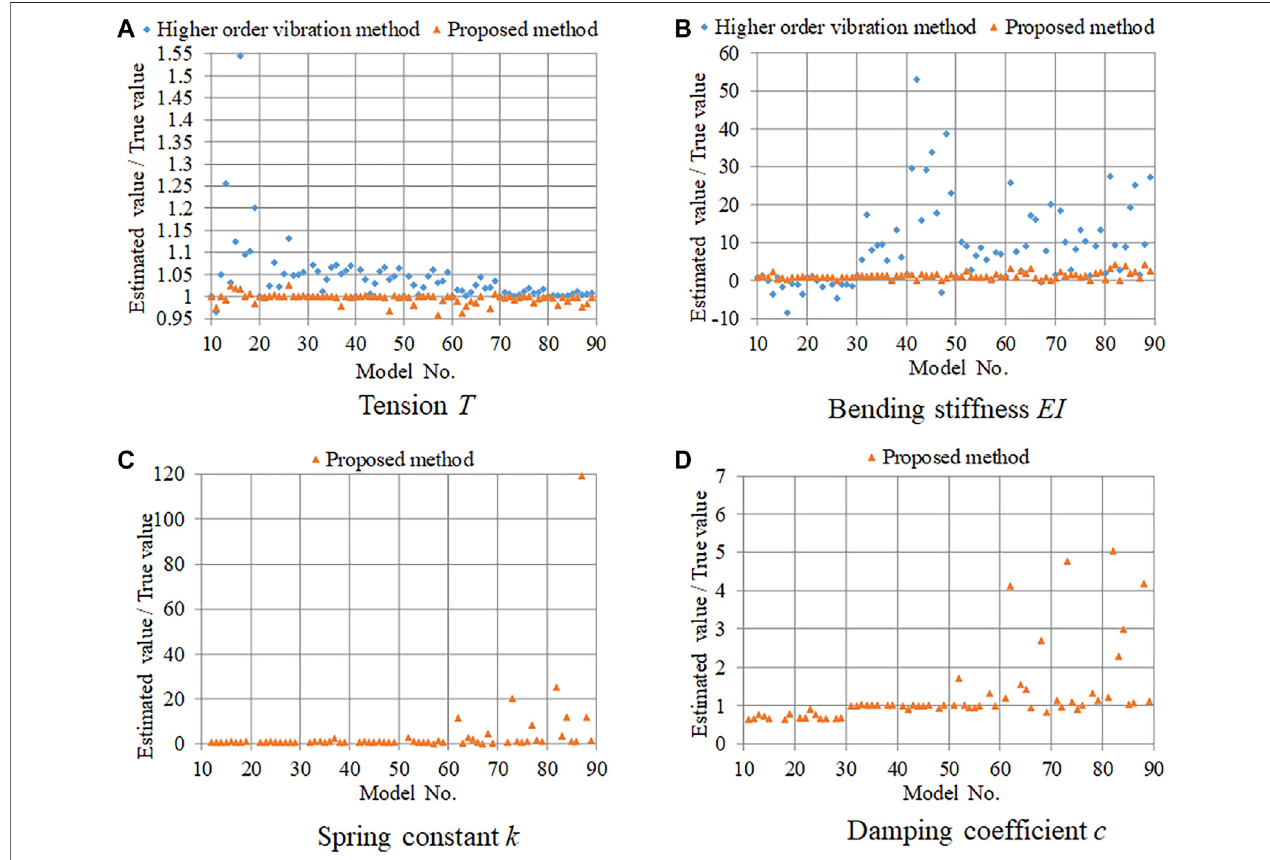
FIGURE 2 | Estimation accuracy of viscous shear damper model: (A) tension; (B) bending stiffness; (C) spring constant; (D) damping coef fi cient.